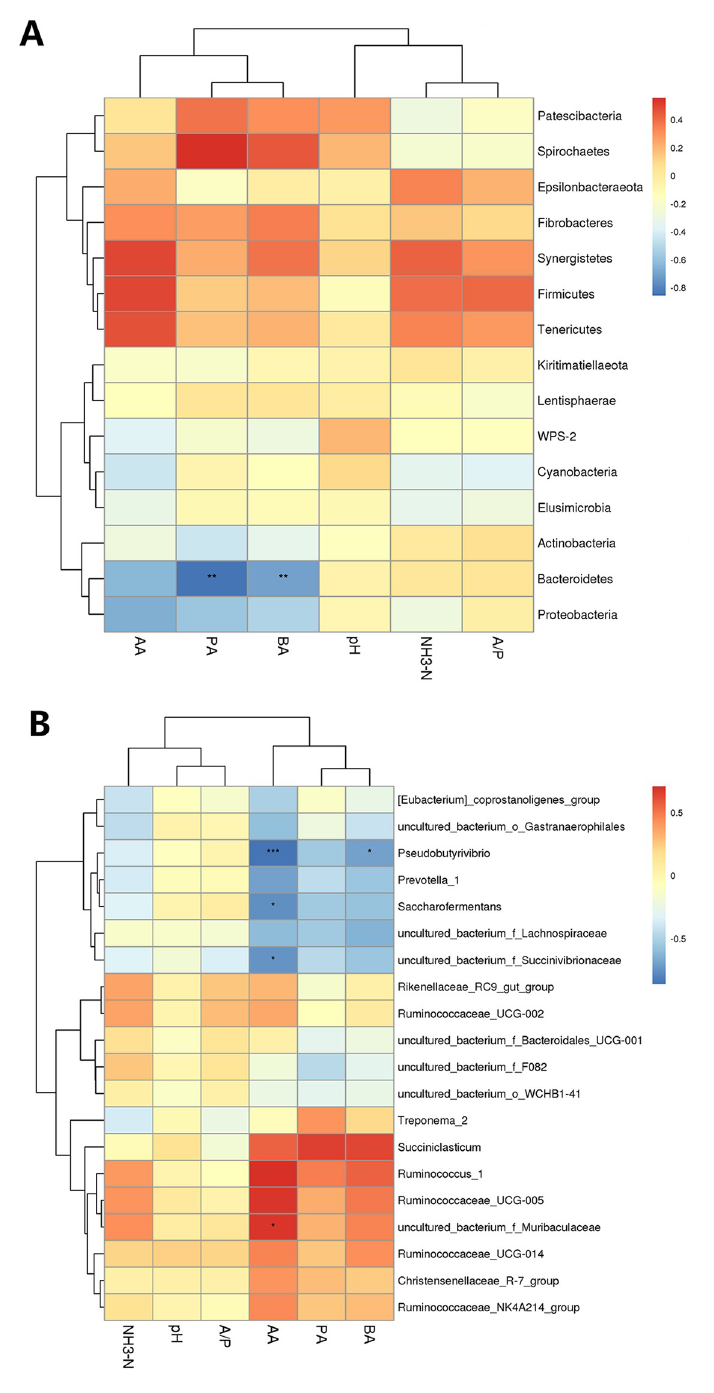
Fig 4. Thermogram of Pearson’s correlation between bacterial abundance (at the (A) phyla- and (B) genera level) and fermentation index. The fermentation indexex included pH, acetic acid/propionic acid (A/P), and the concentrations of NH 3 -N, acetic acid (AA), propionic acid (PA) and butyric acid (BA).